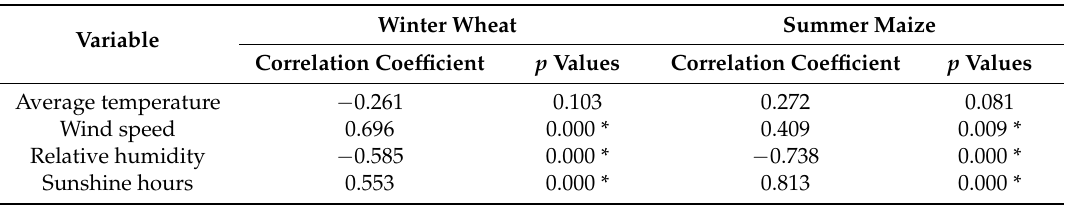
Table 9. Coefficients of correlations between ET 0 and meteorological variables during different seasons from 1969 to 2010.